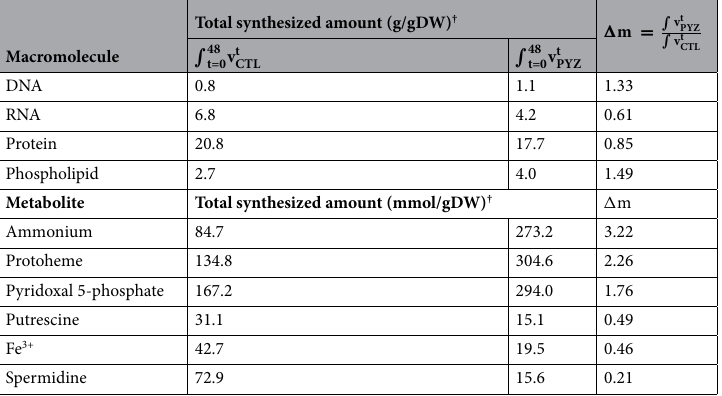
and drug-treated (red markers and curves) parasites. Our model predicted an inhibition of RNA, protein, and polyamine synthesis in the treated parasites (Fig. 4A–C). By contrast, our model predicted an increase in rates of lipid synthesis, cofactor synthesis, and inorganic ion generation in the treated parasites (Fig. 4D–F). To quantify net accumulation or depletion of essential macromolecules and metabolites under both condi- tions, we numerically integrated their synthesis rates in the absence and presence of the drug, and then computed a ratio for each metabolite (and macromolecule) using the values obtained for untreated and drug-treated para- sites (denoted by Δm). Table 3 lists Δm of select essential macromolecules and metabolites. The model predicted a net accumulation of approximately 30% and 50% in DNA and phospholipids, respectively, in the treated parasites (Table 3). In contrast to DNA and phospholipid accumulation, the model predicted a net depletion of approximately 40% and 15% in RNA and protein macromolecules, respectively, in the treated parasites (Table 3). Table S4 tabulates Δm of all essential macromolecules and metabolites. Vaidya et al. 10 found that treatment of malaria parasites by lethal doses of pyrazoleamide compounds disrupts its sodium ion homeostasis, which is essential for phosphate uptake via PfPiT 29 . Our model predicted inhibition of PfATP4 and PfPiT activities in the pyrazoleamide-treated parasites (Fig. S1). As compared to untreated con- ditions, our integrated data and model analysis predicted substantially less efflux of cytosolic protons from the pyrazoleamide-treated parasites under steady-state conditions (Fig. S1). Interestingly, several experiments 5,7,10